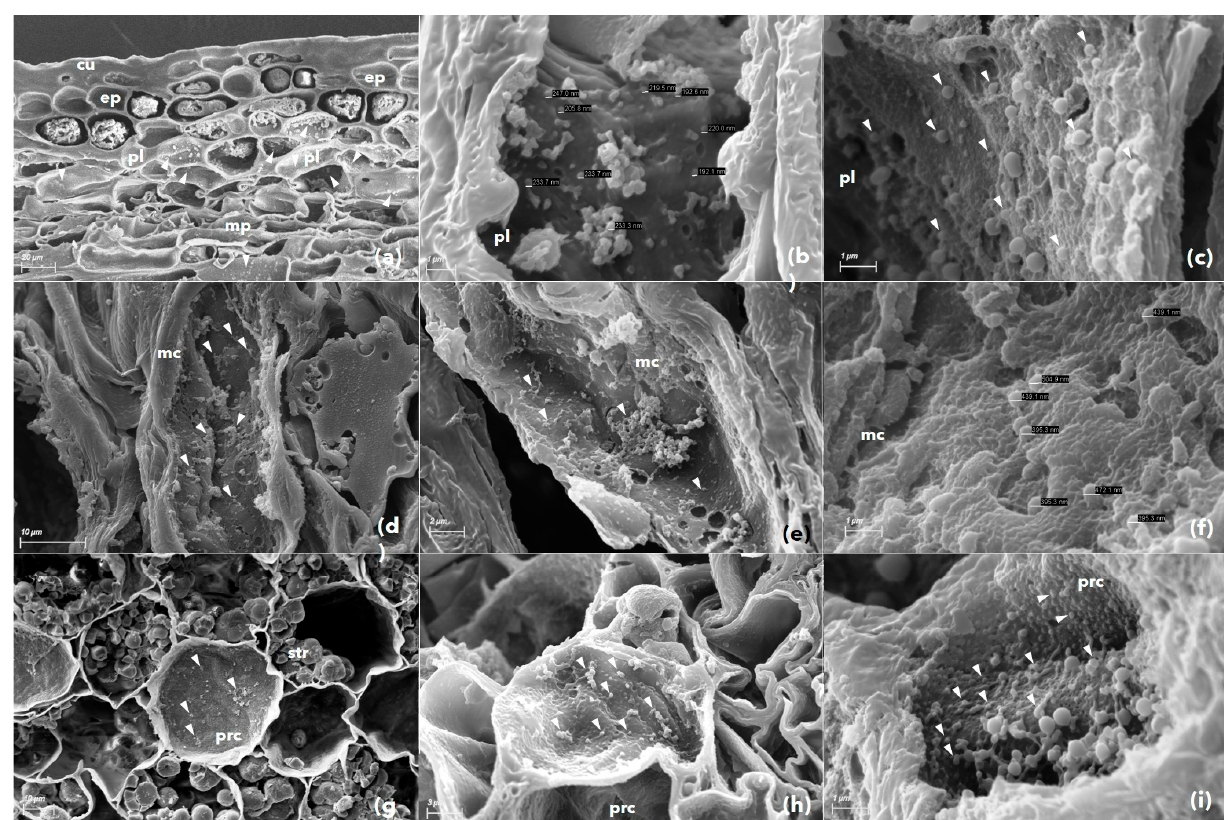
Figure 7. Visualization of phytoplasma cells in various tissues of sandalwood. SSD phytoplasma cells were observed in symptomatic sandalwood leaf tissue ( a – c ), in fruit mesocarp ( d – f ), and in hypocotyl tissue of sandalwood seedling ( g – i ). The location of the phytoplasma cells is indicated by the solid white triangle and the scale bars ( b , f ). cu, cuticle; ep, epidermal cells; pl, palisade cells; mp, mesophyll; ms, mesocarp and prc, parenchyma.